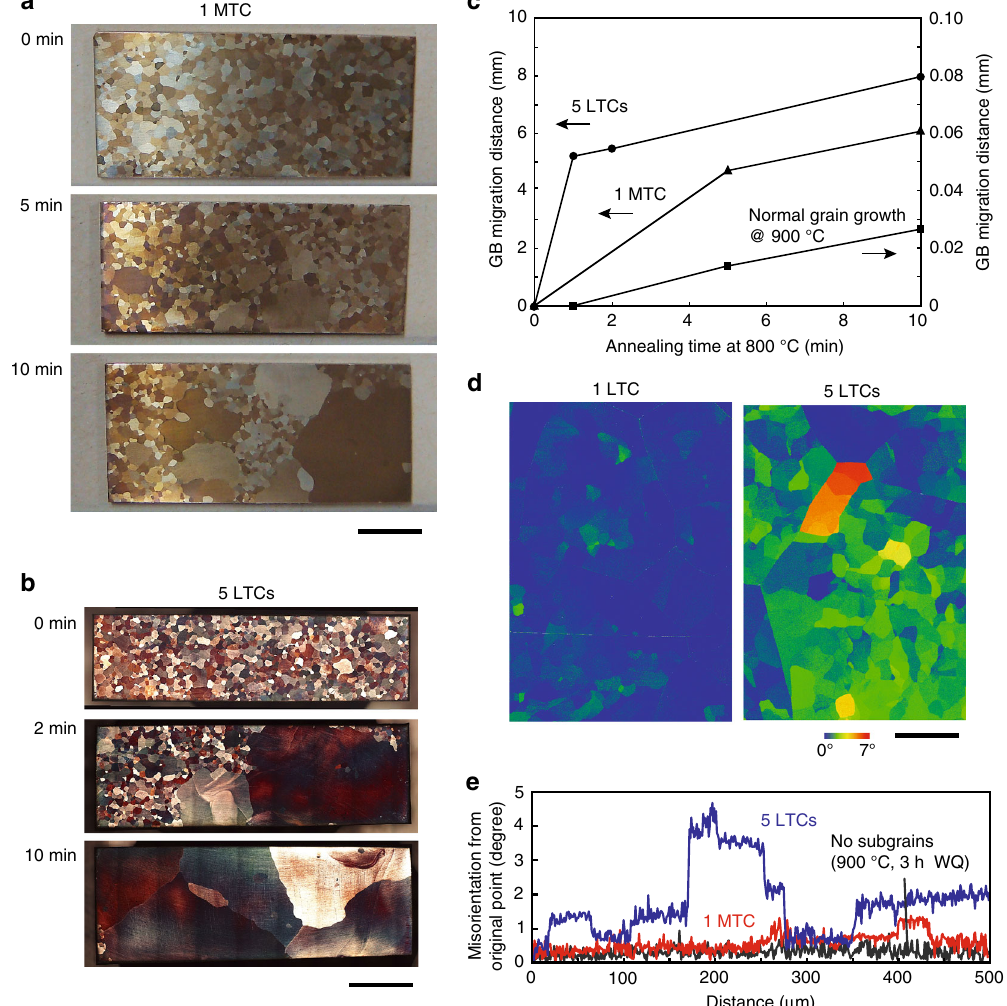
Fig. 4 Grain boundary (GB) migration distance and subgrain structure. a Microstructure of Cu-Al-Mn sheets subjected to one middle-temperature cycle (MTC) (800 – 500 – 800°C) followed by quenching after continuous holding at 800 °C for different periods from 0 to 10 min (Supplementary Fig. 4b). Scale bar , 5 mm. b Microstructure subjected to fi ve low-temperature cycles (LTCs) (740 – 500 – 740 °C) and heated to 800 °C, followed by quenching after holding for different periods from 0 to 10 min (Supplementary Fig. 4c). Scale bar , 5 mm. c GB migration distance experimentally determined for abnormal grain (AG) shown in Fig. 4a, b obtained after one MTC and fi ve LTCs (Supplementary Fig. 4b, c) as a function of annealing time at 800 °C in Cu-Al-Mn alloy. GB migration distance in the normal grain growth (NGG) mode by isothermal heat treatment at 900 °C is also shown for comparison 31 . d Grain reference orientation deviation (GROD) mapping for specimen subjected to one LTC (Supplementary Fig. 4d) and fi ve LTCs (Supplementary Fig. 4e). It is obvious that the orientation mismatch among subgrains after fi ve LTCs is larger than that after one LTC. Scale bar, 200 μ m. e Misorientation from original point in one LTC (Supplementary Fig. 4d) and fi ve LTC (Supplementary Fig. 4e) specimens of Cu-Al-Mn alloy. Data without subgrains are also shown